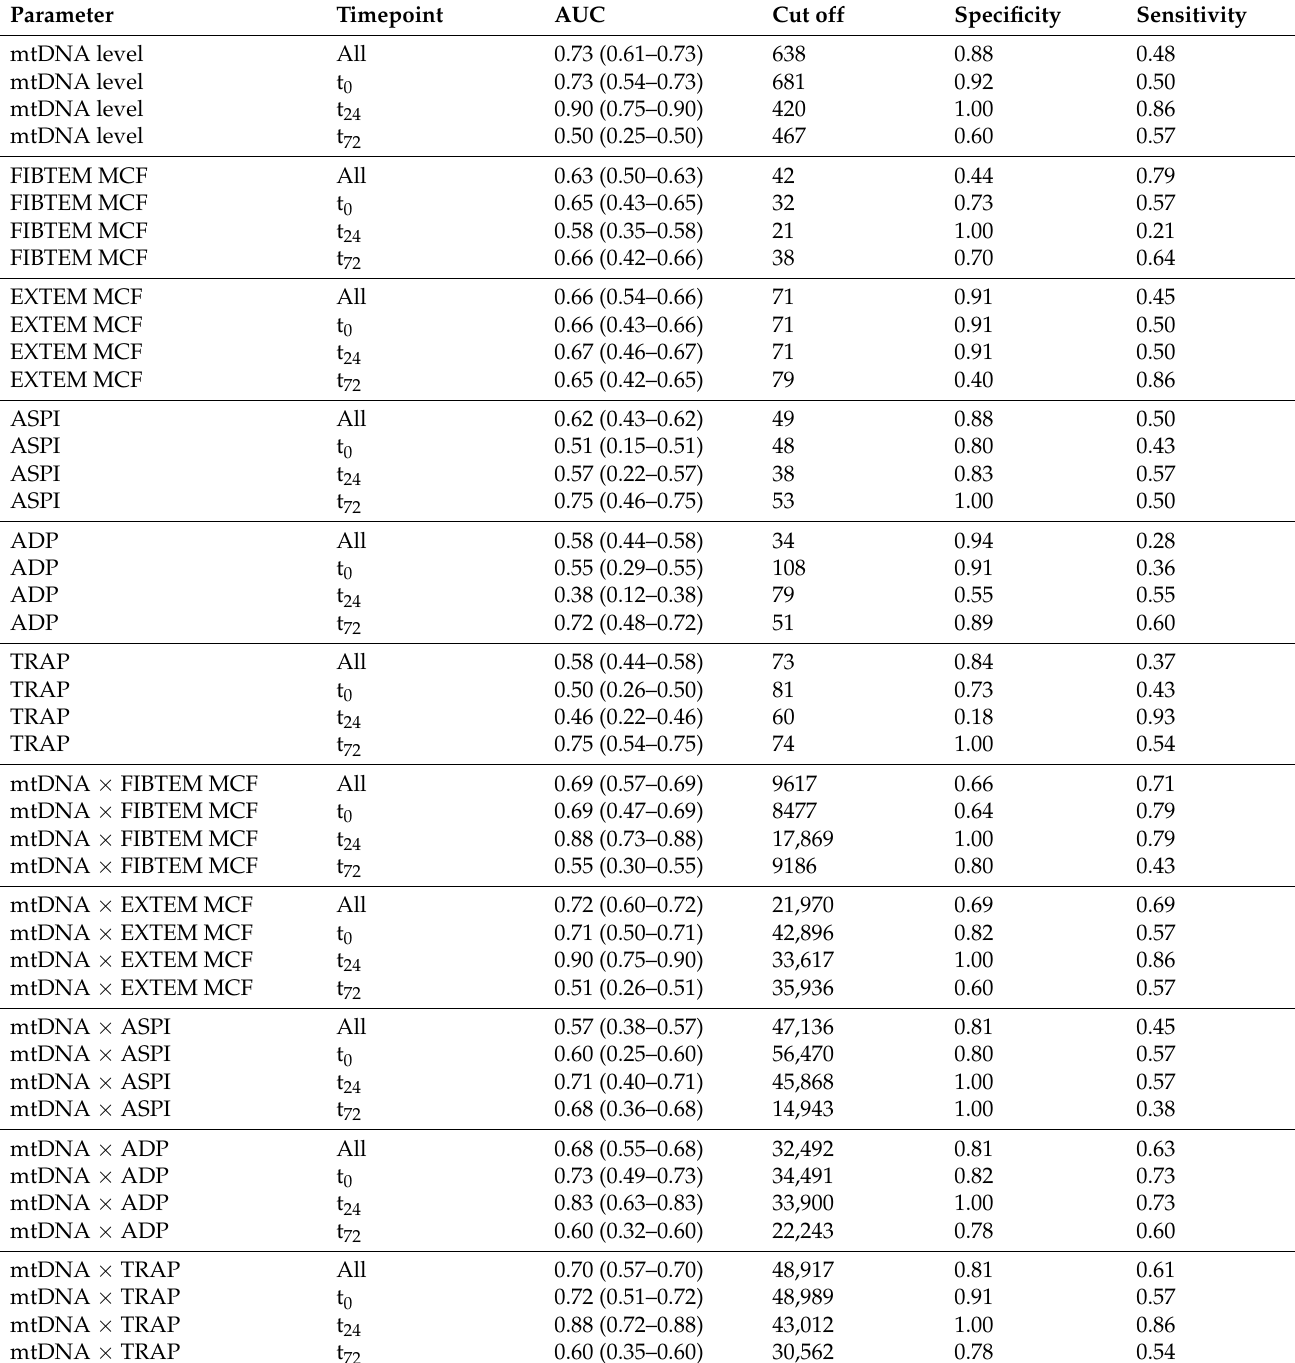
Table 2. AUC with 95% confidence interval for the prediction of